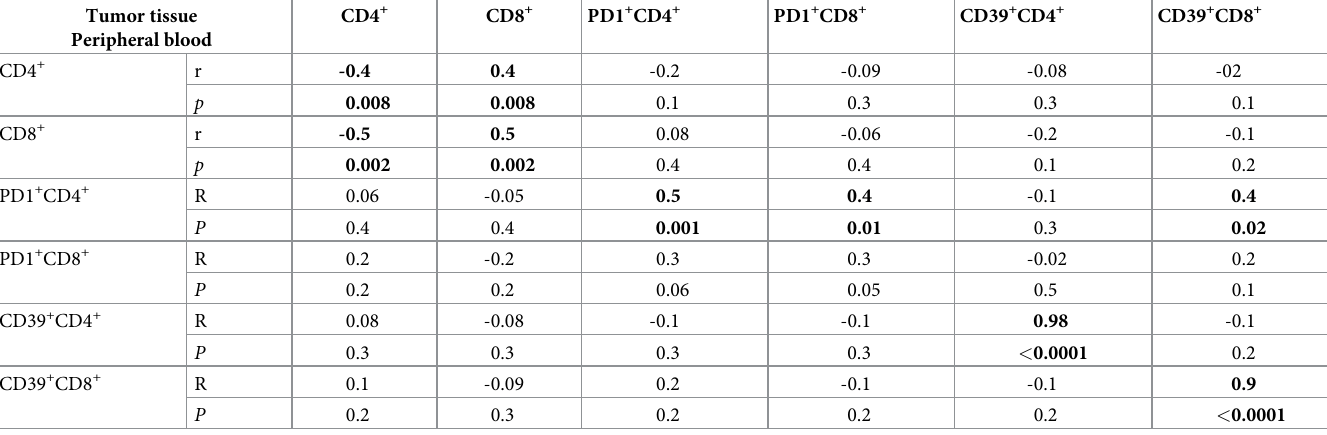
Table 5. Correlations between tumor tissue and peripheral T lymphocyte subsets in patients with triple-negative breast cancer. Tumor tissue Peripheral